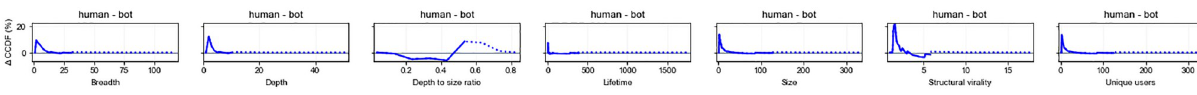
Fig 12. Differences in information spread for root tweets posted by users predicted as humans versus bots. Differences are taken between CCDFs for humans versus bots. Spikes above 0 demonstrate larger numbers for humans. Spikes below 0 demonstrate larger numbers for bots.